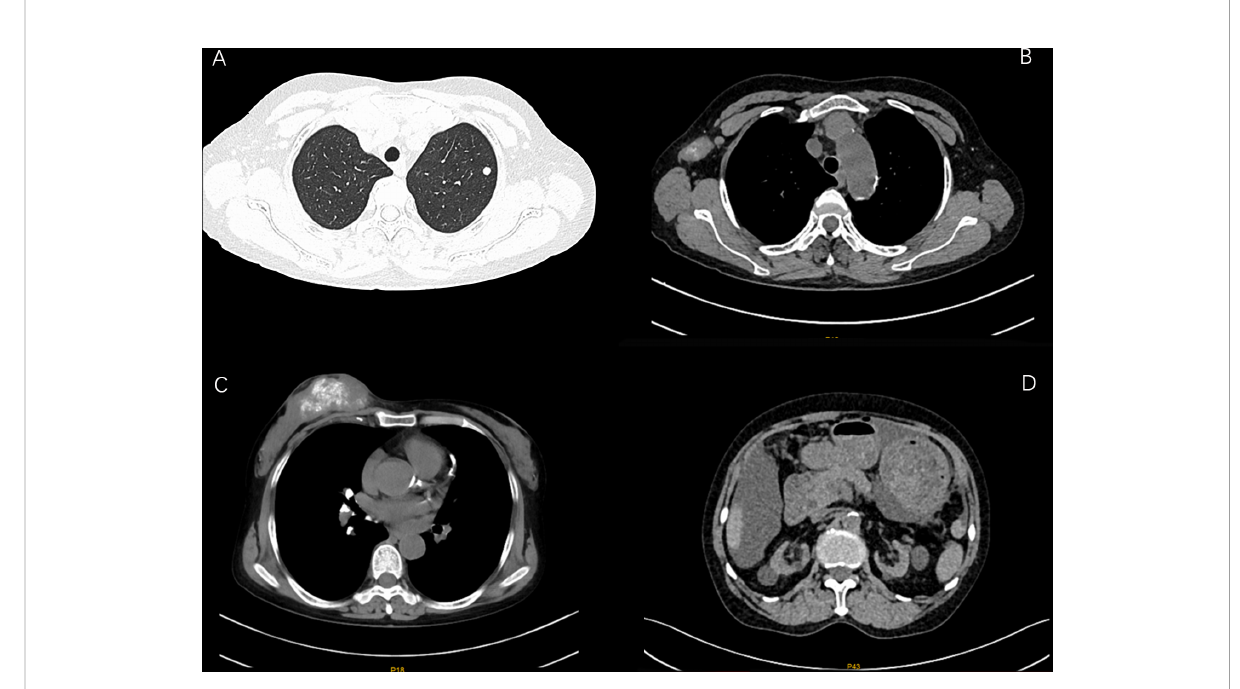
FIGURE 1 CT images of patient before anti -tumor treatment ( A : lung nodules B : lymph nodes in the armpit C : massive soft tissue density with multiple calci fi cations in the right breast D :